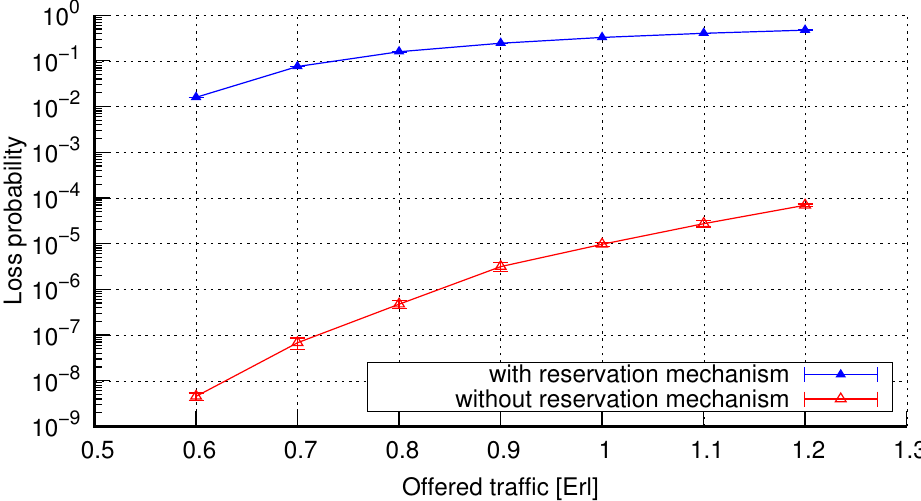
Figure 11. Loss probability for calls of class 1 (non-privileged class) in System